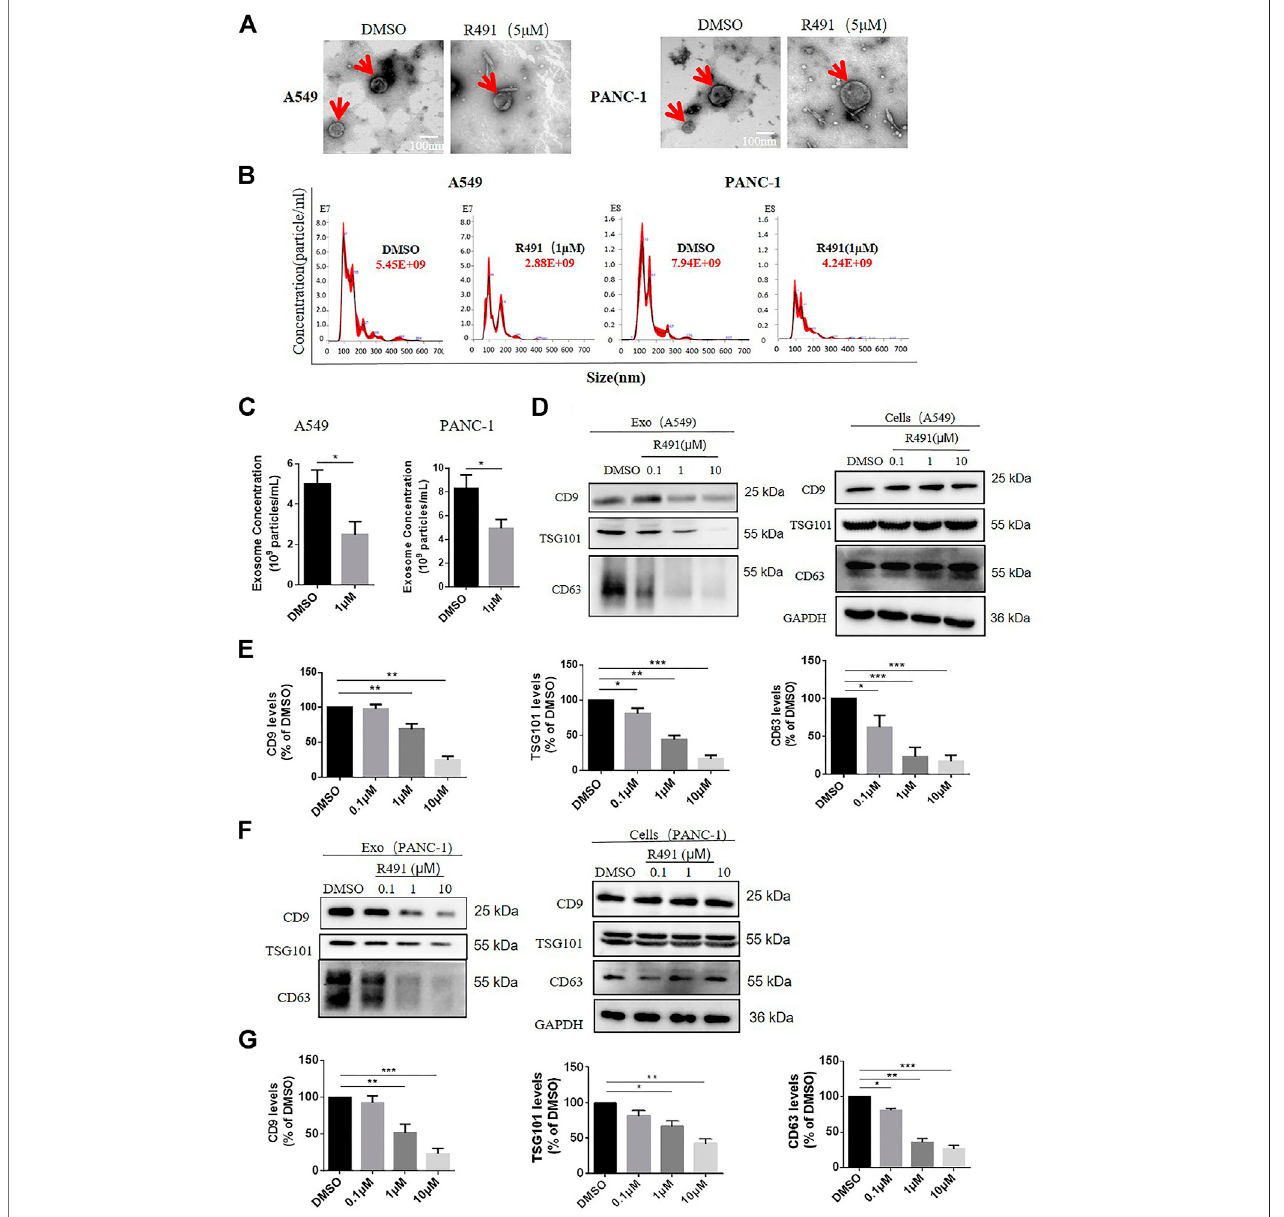
FIGURE 4 | The vimentin-binding compound R491 inhibited exosomes secretion rather than exosomes generation. (A) Representative transmission electron micrographsofexosomes(redarrows)puri fi edfromA549andPANC-1cellstreatedwithDMSO orR491at5 µM scalebars:100 nm. (B) Nanoparticletracking analysis (NTA)ofsmallextracellularvesicles(sEVs)releasedfromA549andPANC-1cellstreatedwithDMSOorR491at1 µMsEVswereisolatedbyserialultracentrifugationfrom cell culture supernatants of same number of cells. (C) NTA quanti fi cation of three independent experiments. (D) Western blot analysis of A549 cells treated with DMSOorwithR491at0.1,1,and10 µMfor48 h.ExtractsfromcellsandsEVs(Exo)wereblottedfortheexosomalmarkersCD9,CD63,andTSG101. (E) Quanti fi cation of exosomal proteins extractedfrom sEVs ofA549 cellsin three independentexperiments. (F) Western blot analysis ofPANC-1 cells treated withDMSO orwith R491at 0.1, 1 and 10 µM for 48 h. Extracts from cells and sEVs (Exo) were blotted for the exosomal markers CD9, CD63 and TSG101. (G) Quanti fi cation of exosomal proteins extracted from sEVs of PANC-1 cells in three independent experiments.